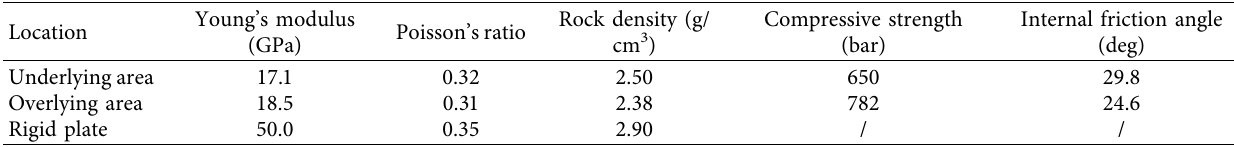
Figure 1: Location diagram of geomechanical grid area. Table 1: Table of mechanical parameters of rock mechanics model surrounding rock area.